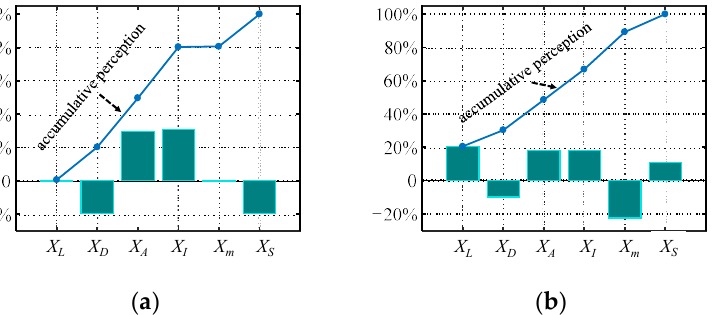
Figure 10. Sensitivity of different factors on the optimal cruise point: ( a ) Sensitivity on Ma opt ; ( b ) Sensitivity on h opt .